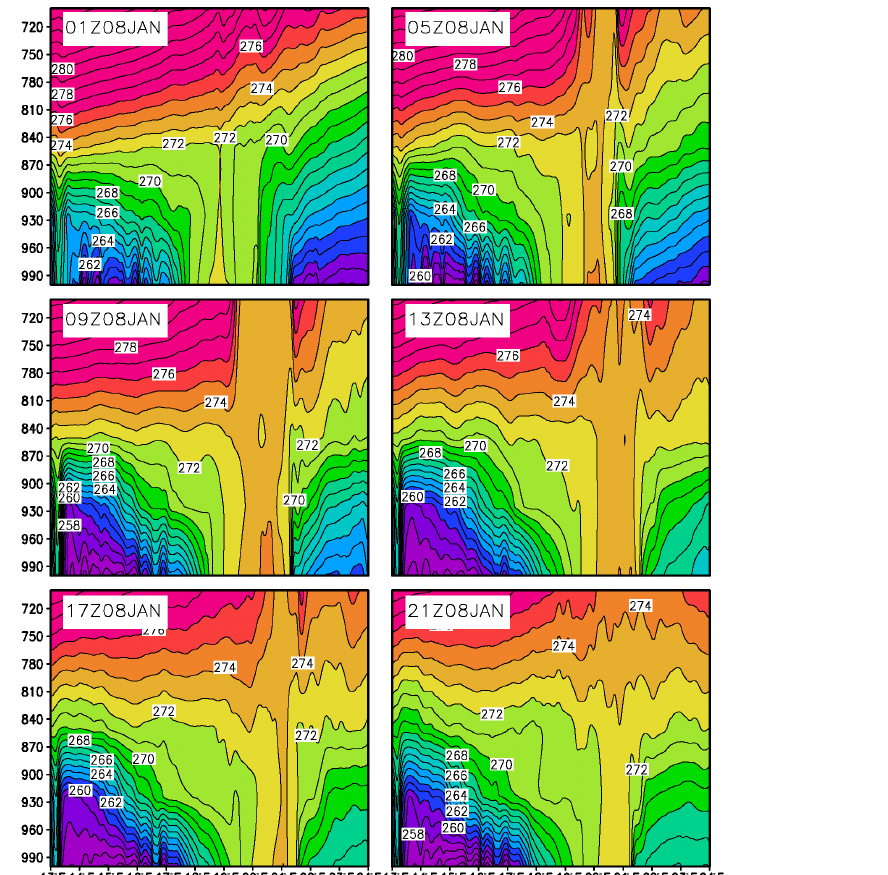
Figure 4. Vertical cross section from 1000 to 700hPa of the equivalent potential temperature (K) along 62 ◦ N, as simulated by HARMONIE, from 01:00UTC (top left panel) to 21:00UTC (bottom right panel), with 6h increments, on 8 January 2016. The sea is located between 17.3 and 21.2 ◦ E, Finland to the east and Sweden to the west. For the latitude of 62 ◦ N and the longitudes, see the horizontal segment line in Fig.